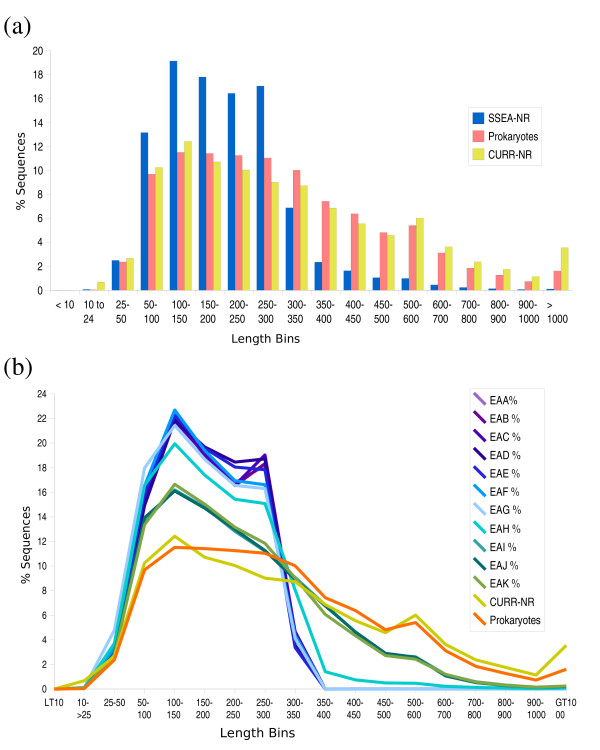
Length distribution for the Sargasso Sea resource. Figure 2a shows the percentages of sequences in each of 18 different length bins. Bars in blue represent the number of sequences in each bin for the SSea-nr database, those in yellow show the corresponding distribution for the Curr-nr database and those in orange show the length distribution for sequences from all completely sequenced prokaryotic genomes. The distribution shows clearly that the lengths of the Sargasso Sea sequences are much more highly concentrated at lengths between 50 and 300 residues. In figure 2b the same bins are used, but the Sargasso Sea sequences are split into their eleven constituent parts. This shows clearly that most of the fragments are to be found in sections "eaa" to "eah". The section "eaa" contained only 21,000 sequences, compared to the 100,000 sequences in the other bins.